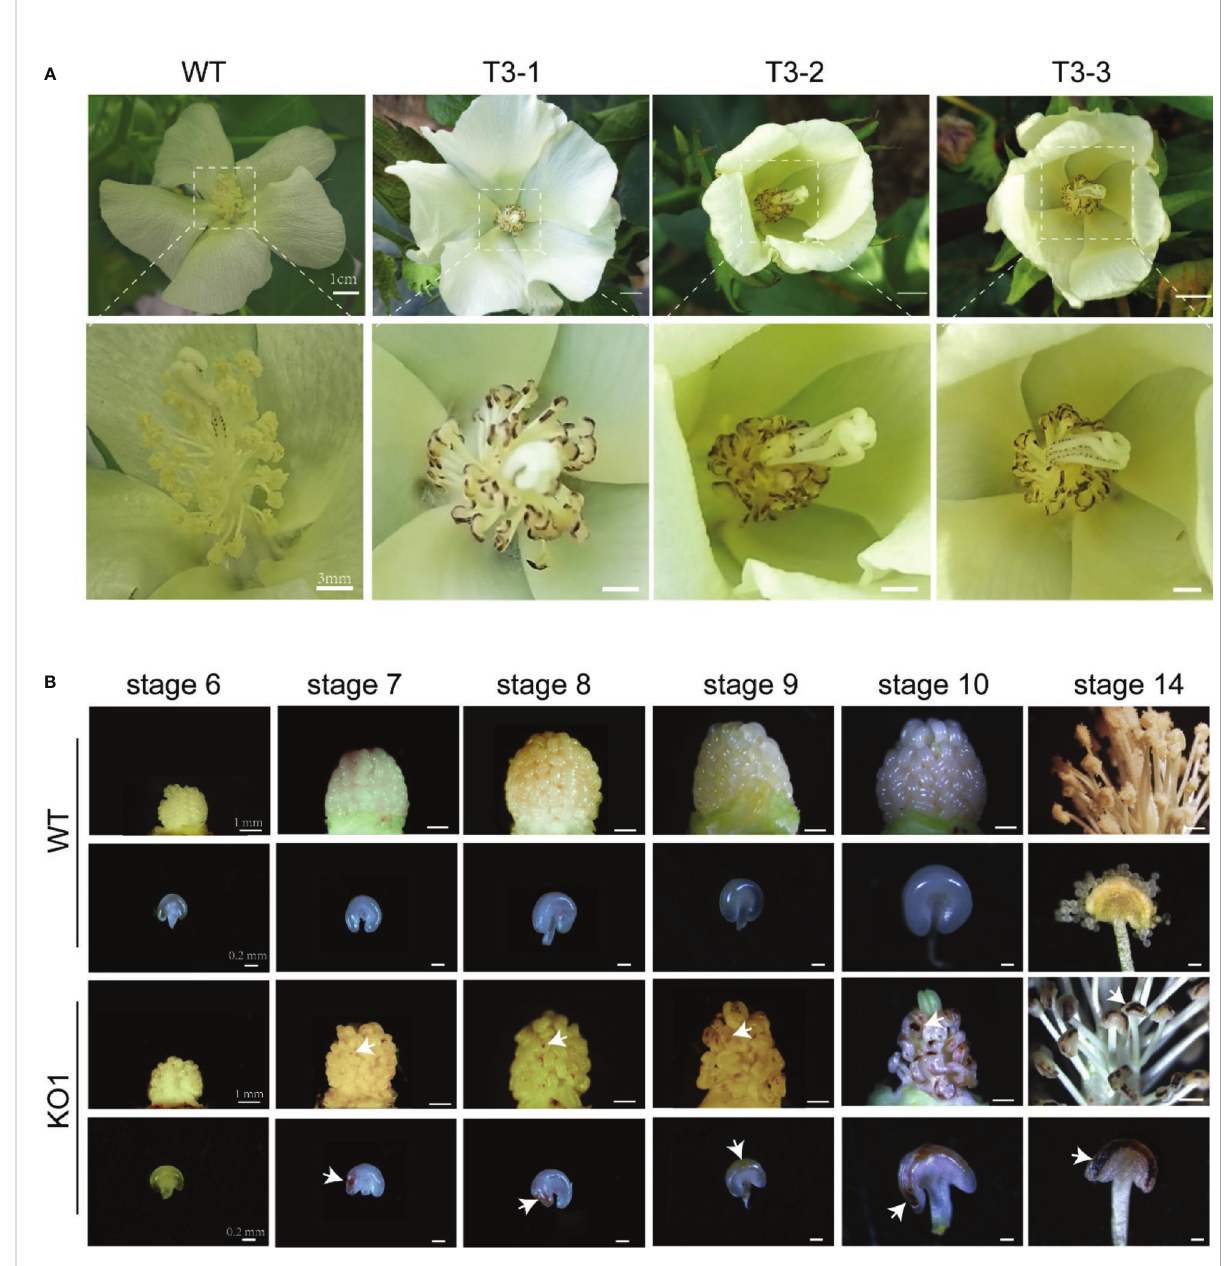
FIGURE 3 The sterile phenotype of surface necrosis of T3. (A) wild type, KO1 T3 plants, and enlarged images. (B) Changes in the anthers with different degrees of necrosis-like spots. Compared with those of the WT, yellow spots appeared on the anthers of sterile KO1 plants at stage 7, these spots gradually deepened at stage 10 and stage 14 to form necrosis-like dark spots eventually. KO1, GhEMS 3-genes simultaneous mutant. The white arrows indicate necrotic